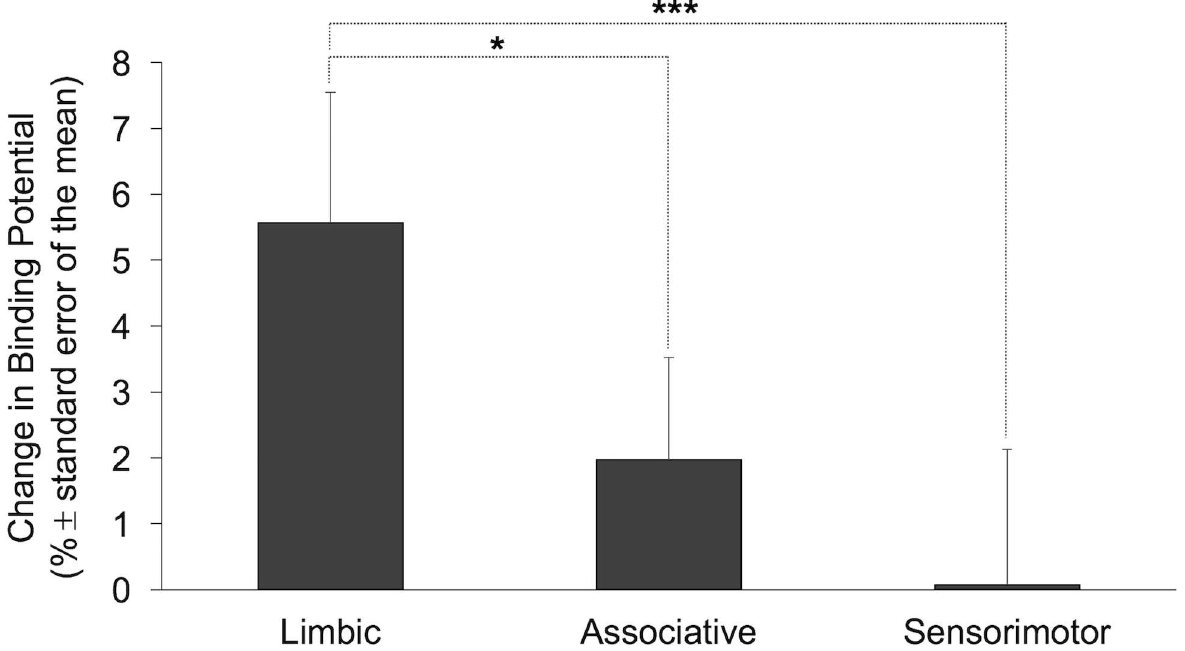
Fig 2. Amphetamine-induced changesin binding potentials. Amphetamine-inducedchanges (%) in bindingpotentials ( Δ BP ND ± standarderrorof the mean)in the limbic,associativeandsensorimotor striatum.More positive Δ BP ND valuesreflectgreateramphetamine- induceddopamine release( * p < .05and *** p = .001,respectively).